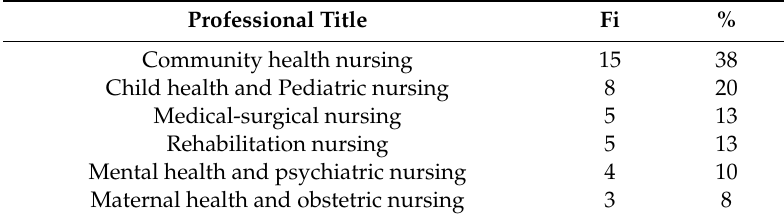
Table 2. Focus group participants profile concerning nursing specialties.